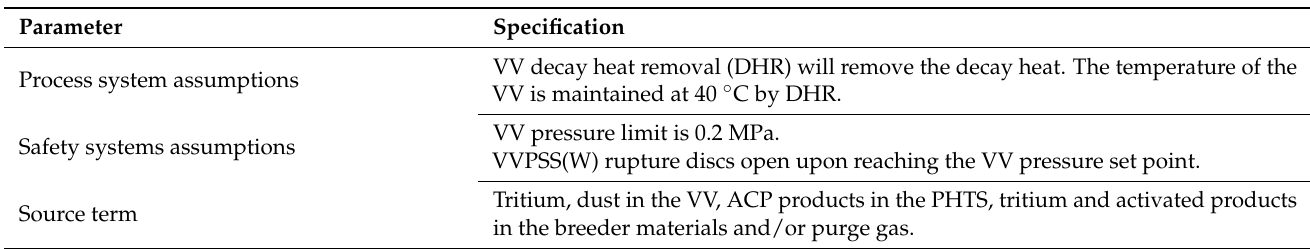
Table 9. Accidental scenario system